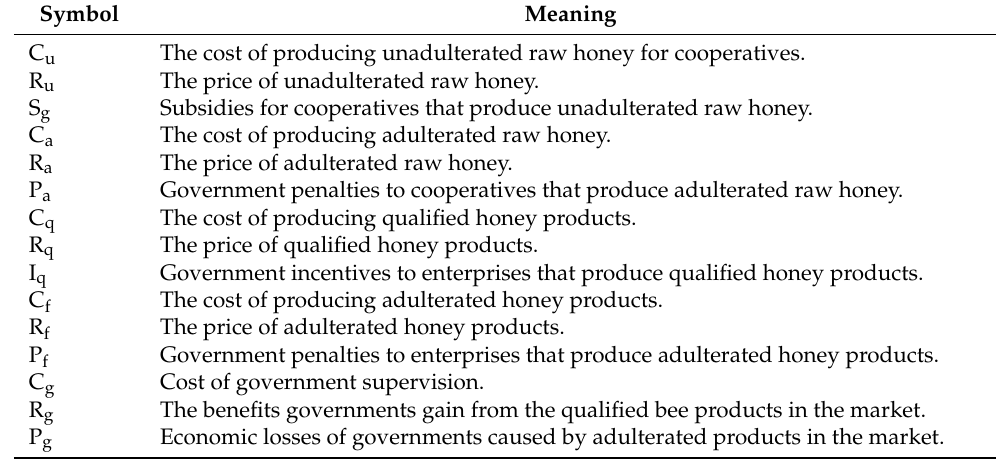
Table 1. Parameter description.